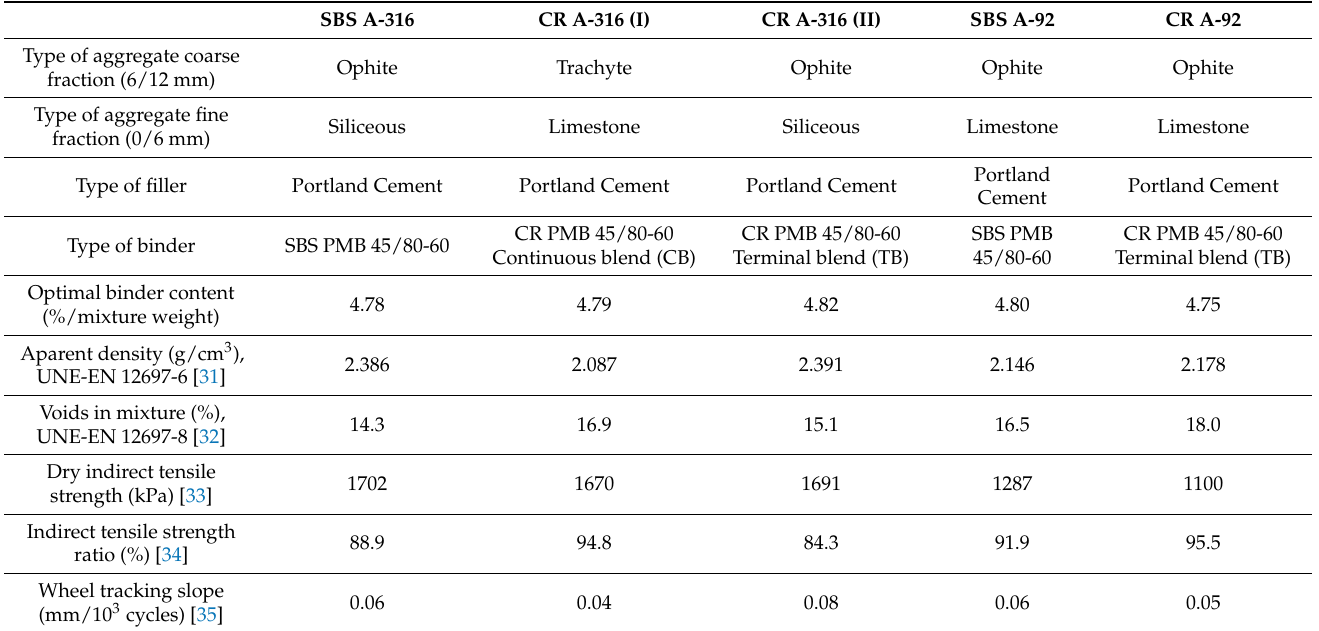
Table 2. Characteristics of the job mix formulas used in the construction of the highway sections studied.